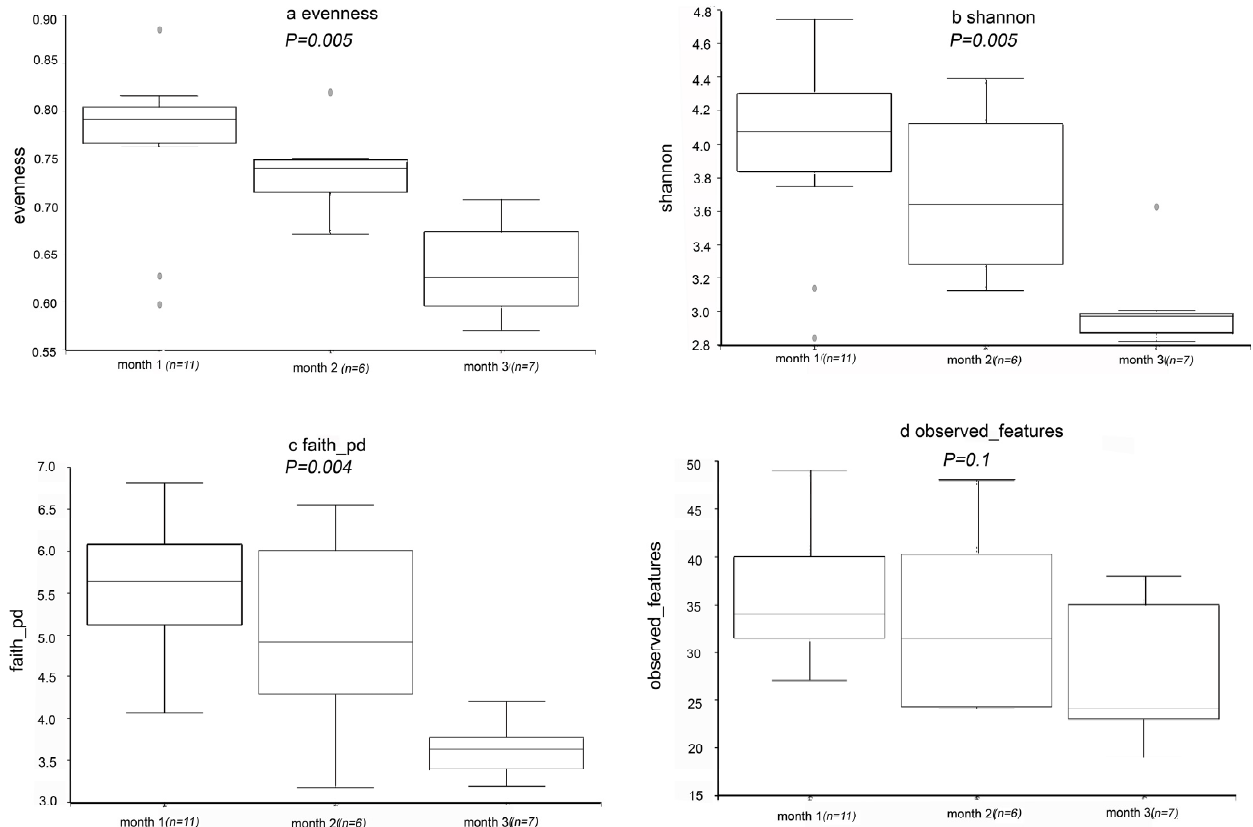
Figure 4. Alpha diversity analysis. Box plot of index differences between groups of ( a ) evenness, ( b ) Shannon’s diversity, ( c ) Faith’s pd and ( d ) observed features at different processing steps.